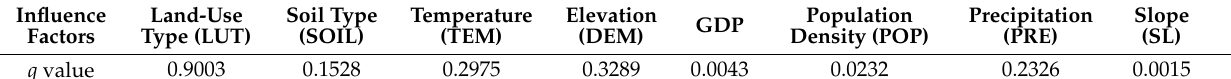
Table 8. Complex drivers of habitat quality change.